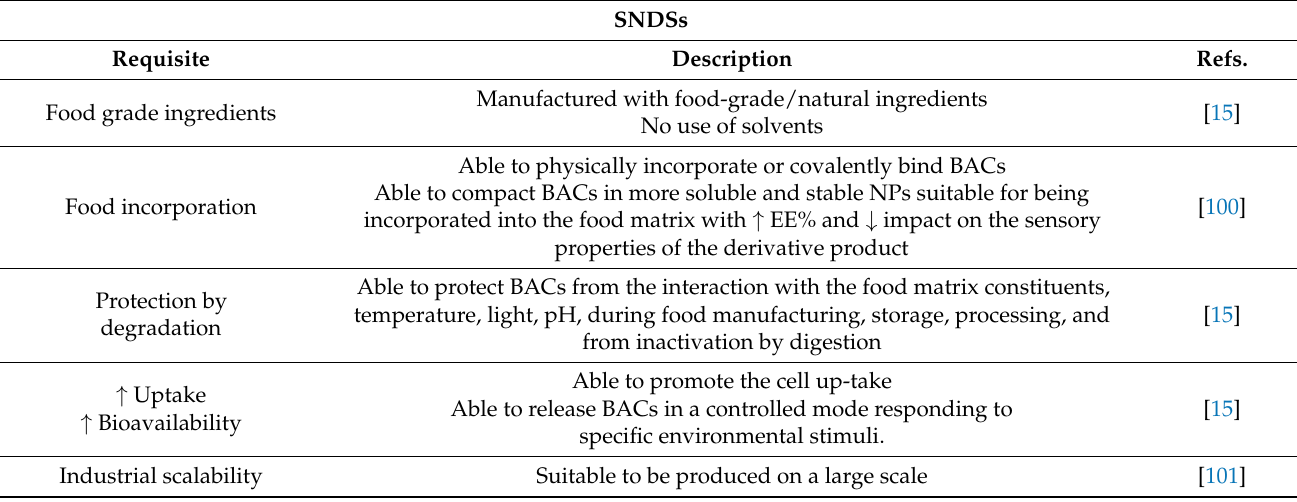
Table 7. The main features that the SNDSs for food uses should